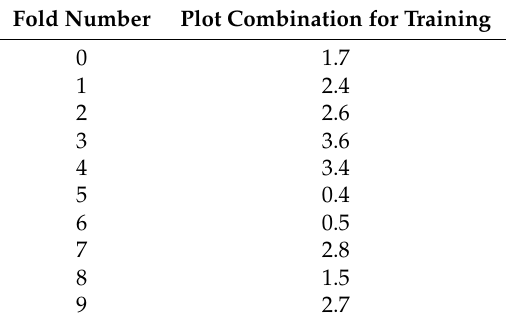
Table 3. Plot combination of each fold in cross-validation. Each detection and segmentation model was trained on one fold. The first number of each pair of plots corresponds to a plot with a brown background. The second number corresponds to a plot with a green background. Refer to Table 2 for plot background colors. For each fold, all plots not used for training were used for